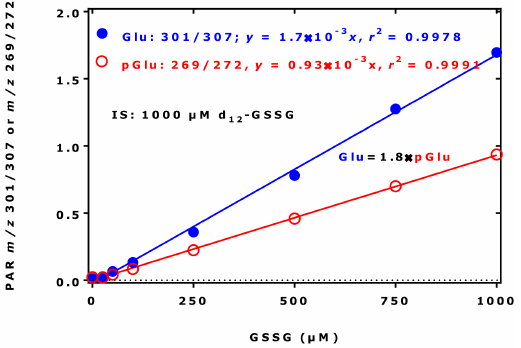
Figure 8. Linear relationship of the peak area ratio (PAR) of m / z 269 to m / z 272 for pGlu (Peak C) and of the PAR of m / z 301 to m / z 307 for Glu (Peak B), and the concentration of GSSG (range, 0 to 1000 µ M), using d 12 -GSSG as internal standard at 1000 µ M. Standard esterification (60 min, 80 ◦ C) and acylation (30 min, 65 ◦ C) were